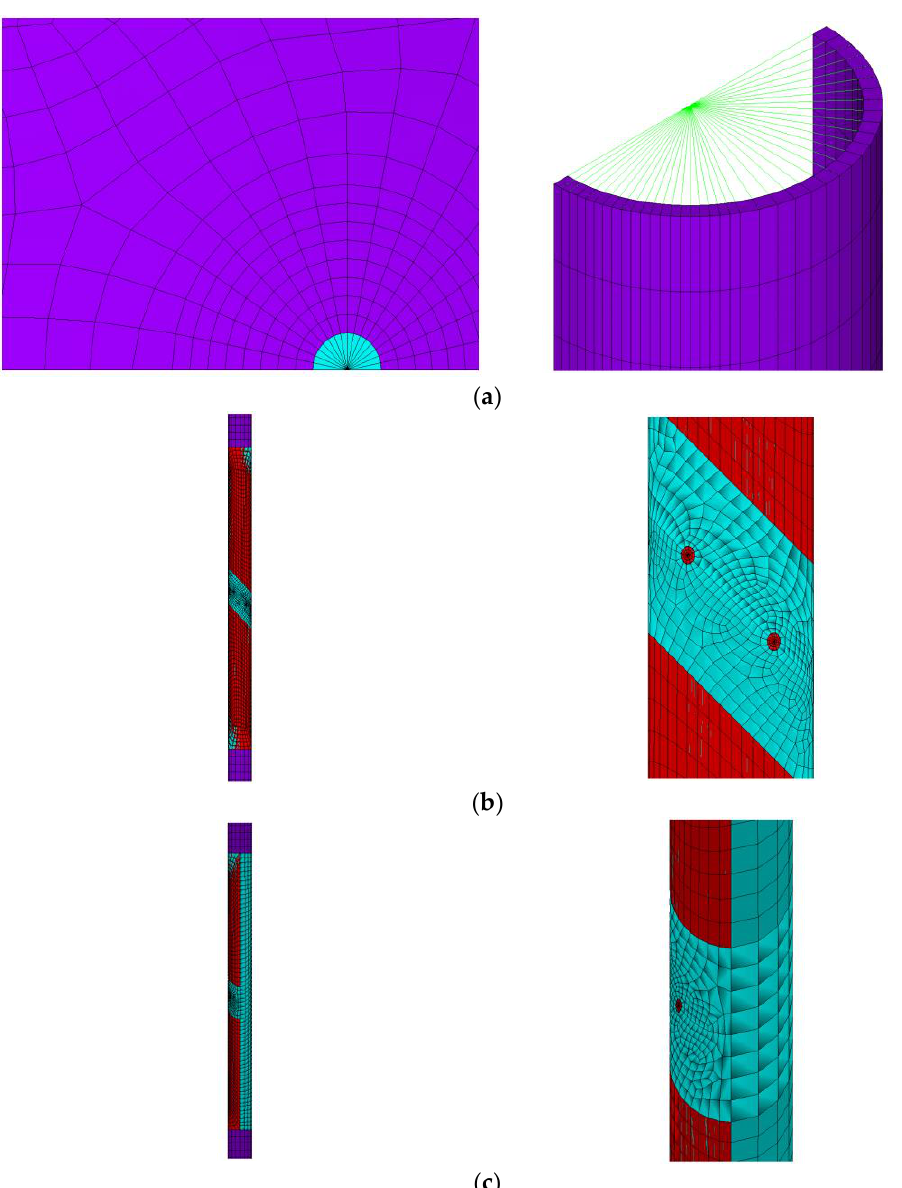
Figure 12. Different elements on models of circumferential cracks and oblique cracks, ( a ) Element distribution of the model with a circumferential crack, ( b ) Element distribution of the model with an oblique crack, ( c ) Element distribution of the model with an oblique crack.